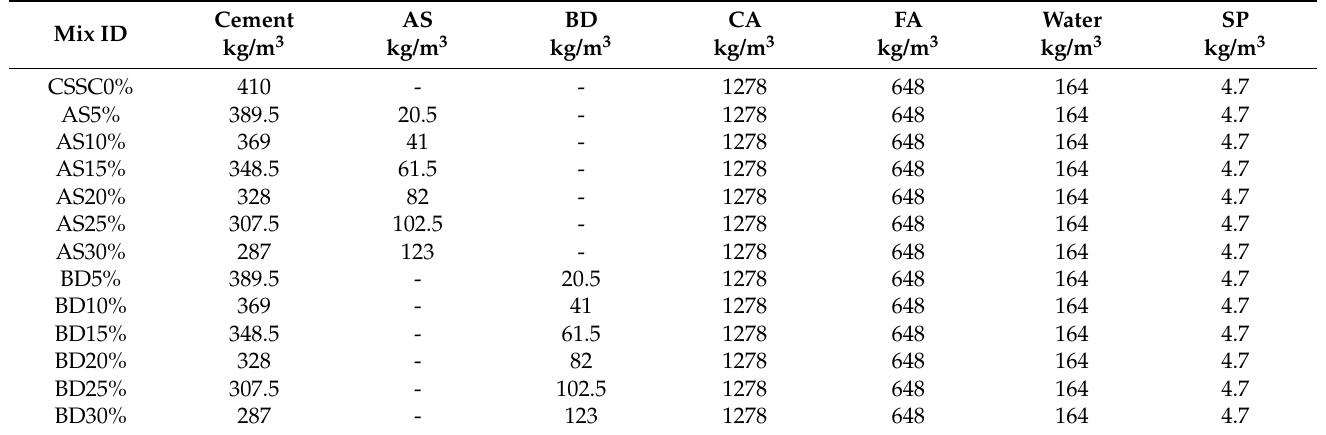
Table 2. Mixing and development rates for building.